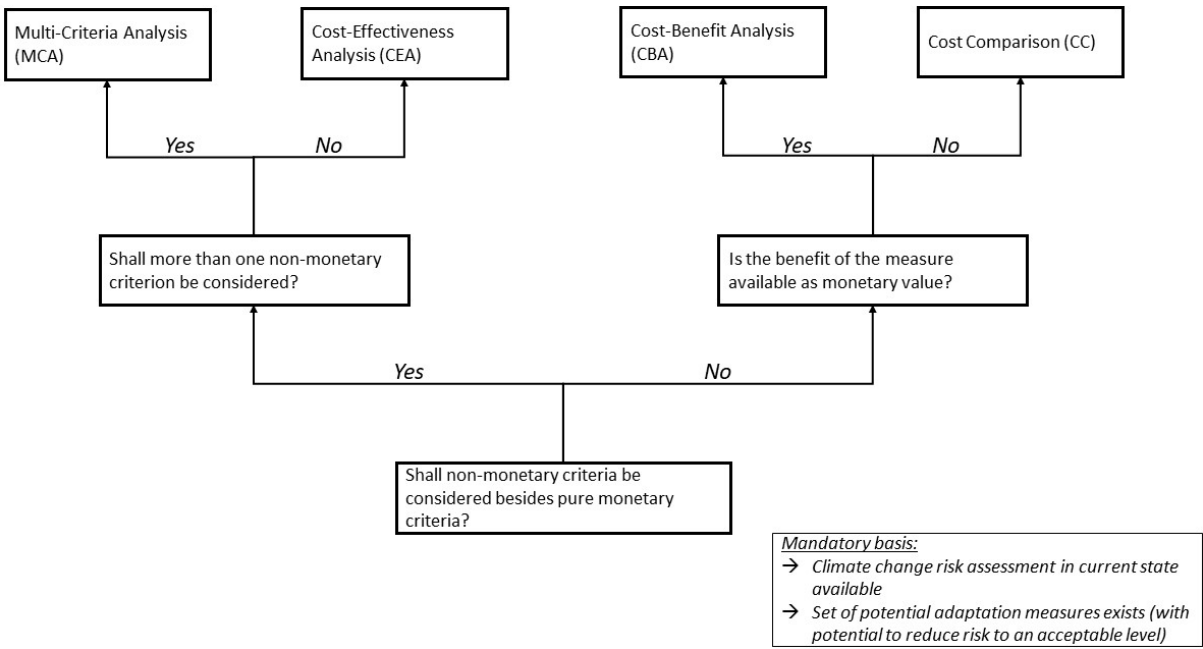
Figure 1. Decision tree supporting the definition process of a fitting analytical framework to evaluate socio-economic implications of climate change adaptation